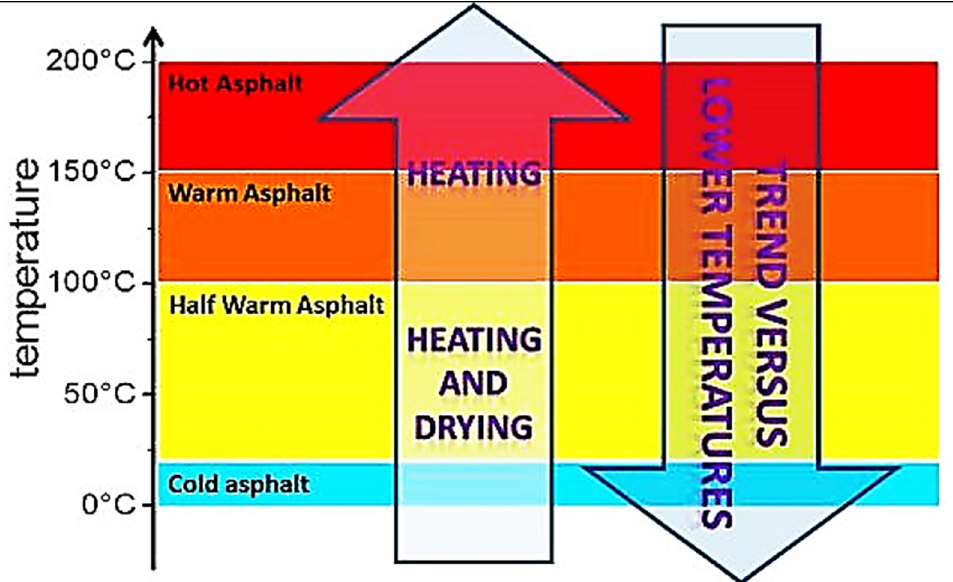
Figure 9. The range of effective temperatures [33].